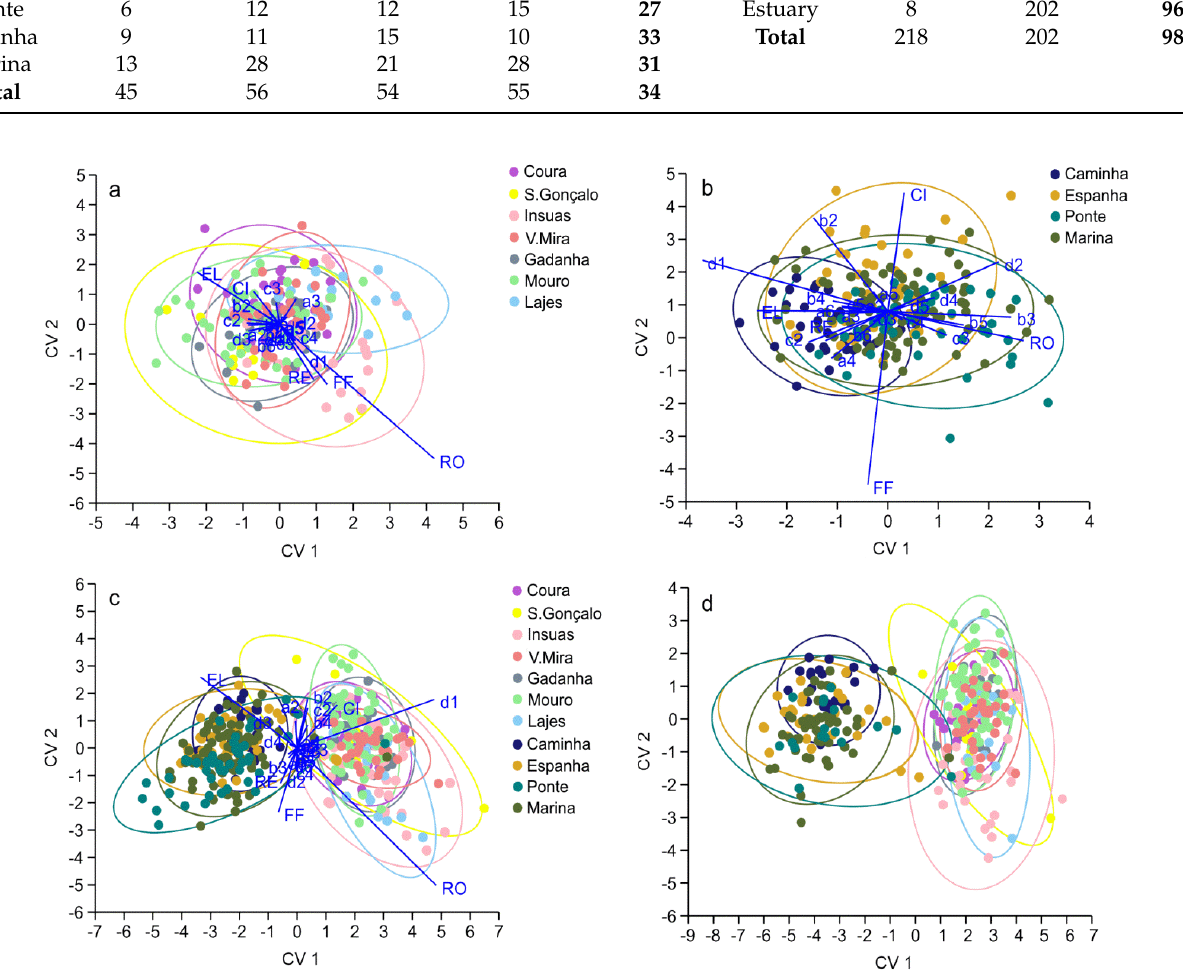
Figure 5. Canonical Variates Analysis (CVA) plot of the otolith shape signature for eels collected in the ( a ) tributaries, ( b ) estuary, ( c ) tributaries and estuary combined, and ( d ) undifferentiated individuals only from the tributaries and estuary.